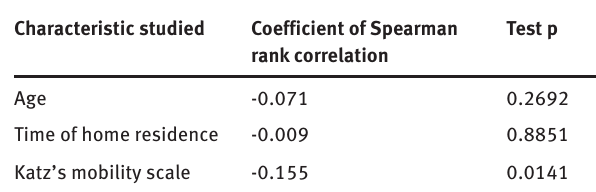
Table 3: DJG scale of loneliness depending on age (5-year brackets)